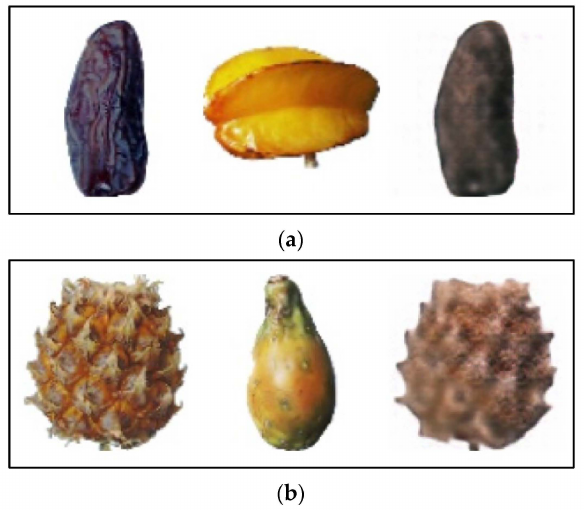
Figure 15. Error cases by the proposed PI-GAN. From the left to right: ( a ) date, carambula, and augmented date; ( b ) pineapple, cactus fruit, and augmented